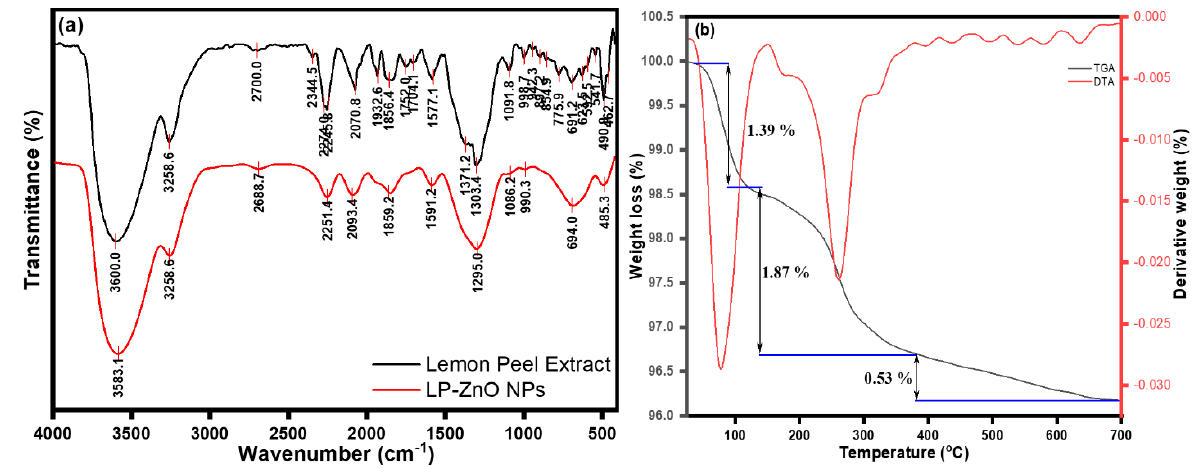
Figure 6. ( a ) FTIR spectra of lemon peel extract and LP-ZnO NPs and ( b ) TGA-DTA plot of LP-ZnO NPs.